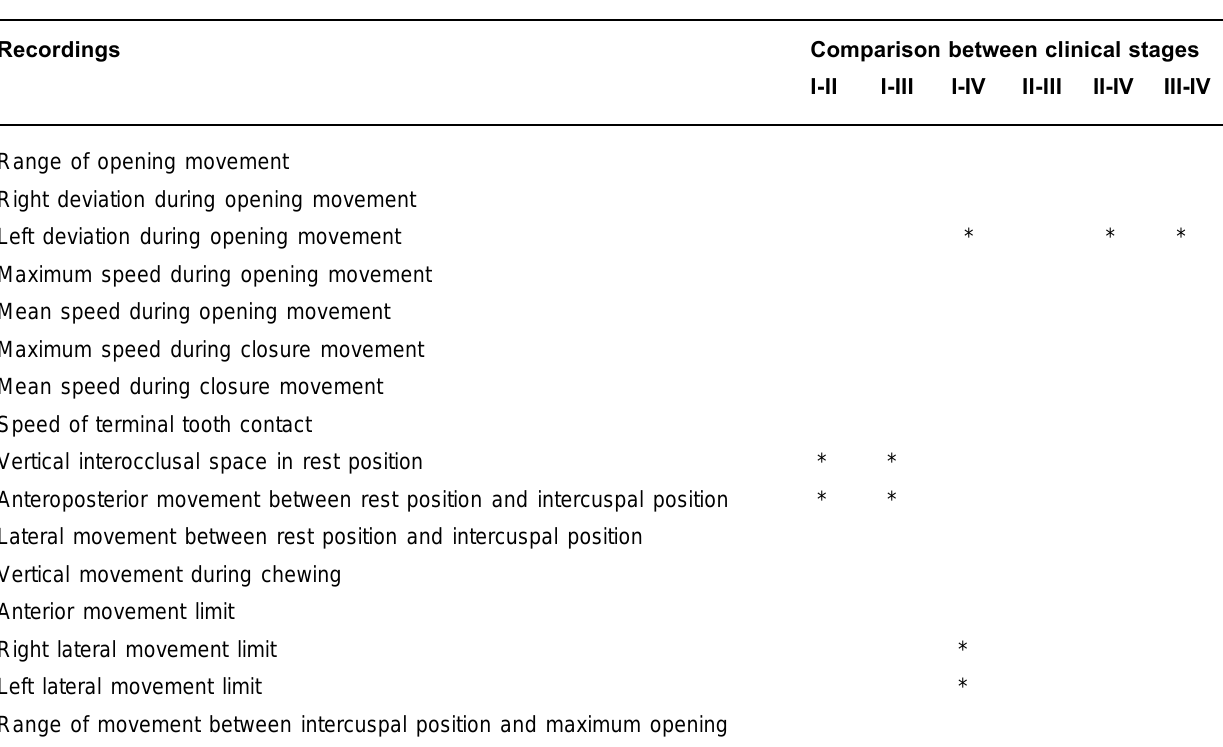
TABLE 11 - Result of measurement